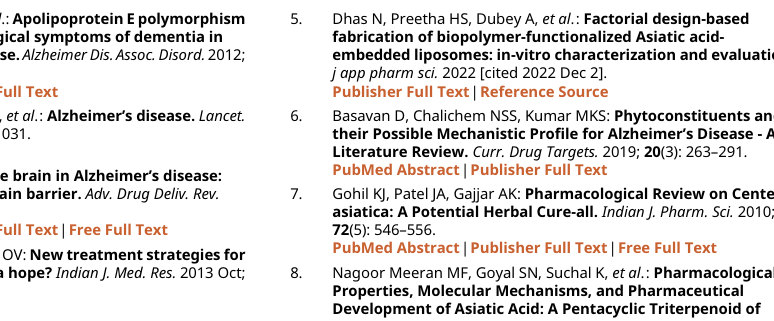
Figshare: Data file 02 - In vivo data, https://doi.org/10.6084/m9.figshare.21485256.v1. 89